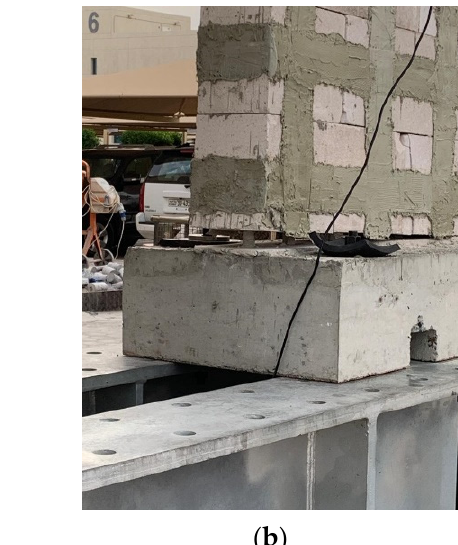
Figure 16. Overall failure of the reinforced wall after testing and before force release.